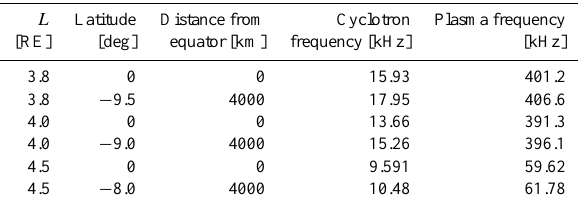
Table 1. Latitude, distance from equator, local cyclotron and plasma frequencies at all the ray tracing start points.